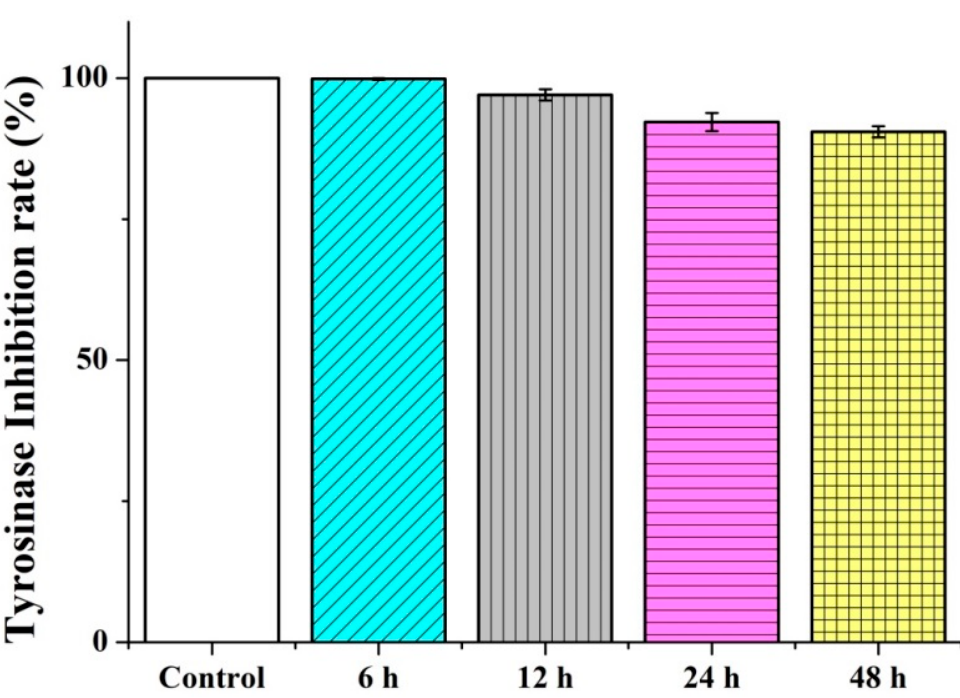
Figure 4. Tyrosinase inhibition rate of P. emblica as related to the extraction time.